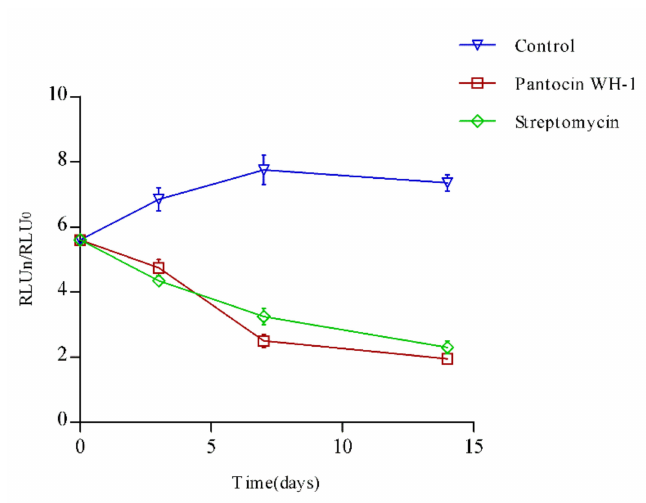
Figure 4. Antimicrobial activity of pantocin wh-1 in a mouse model.